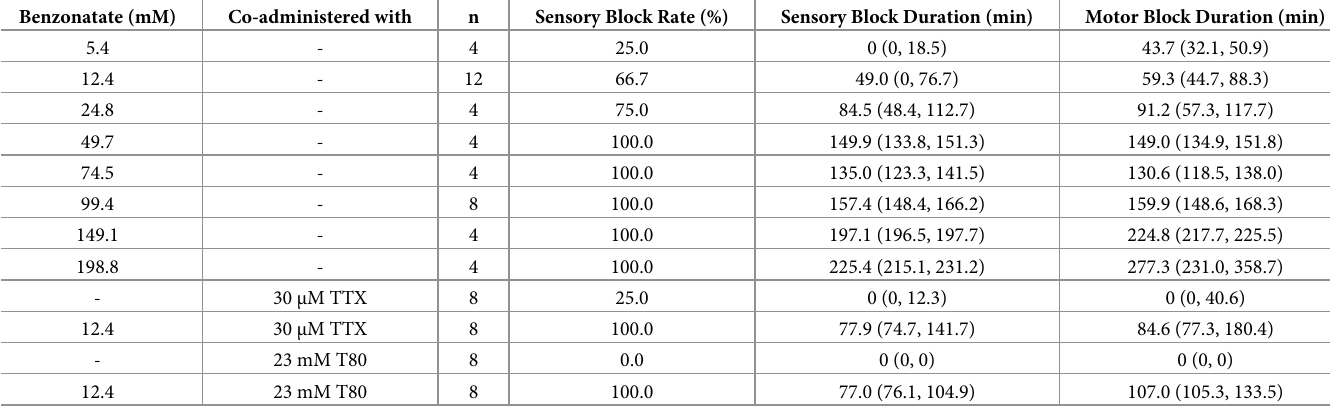
Table 1. Formulations injected at the sciatic nerve. Benzonatate